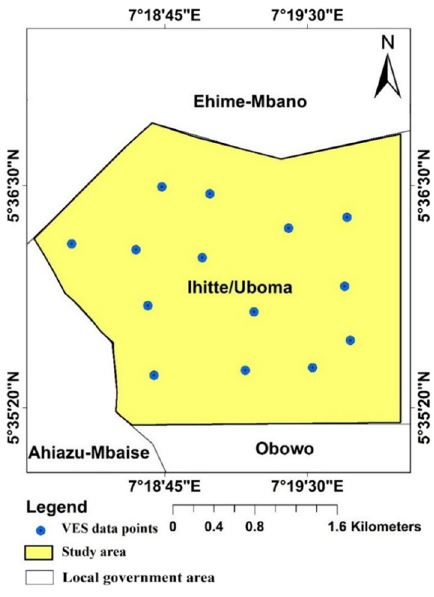
Fig. 2 The distribution of VES data points